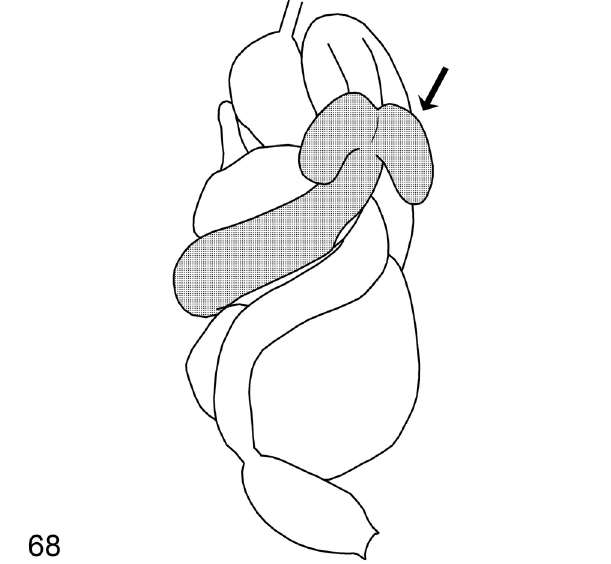
Fig 68. Neocapritermes opacus worker gut in situ , right view (arrow: bilobate protuberance in the distal region of the mesenteric